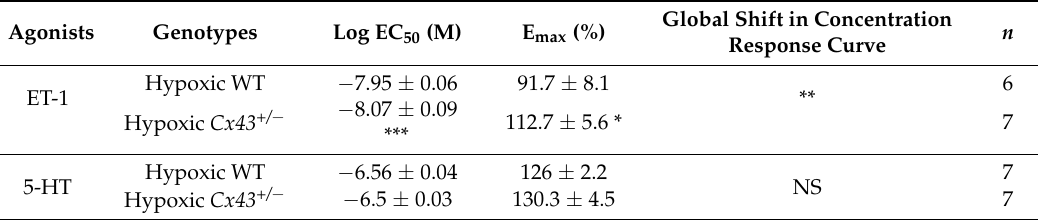
Log EC 50 indicates the logarithm of median effective concentration, E max maximal contractile effect. Global differences in concentration response curves were compared by using two-way ANOVA. Changes in logarithm of median effective concentration (Log EC 50 ) and maximal contractile responses (E max ) between two different groups were analyzed by using the Student’s t- test. NS: not significant * p < 0.05, ** p < 0.01, *** p < 0.001. Data are shown as mean ± S.E.M.